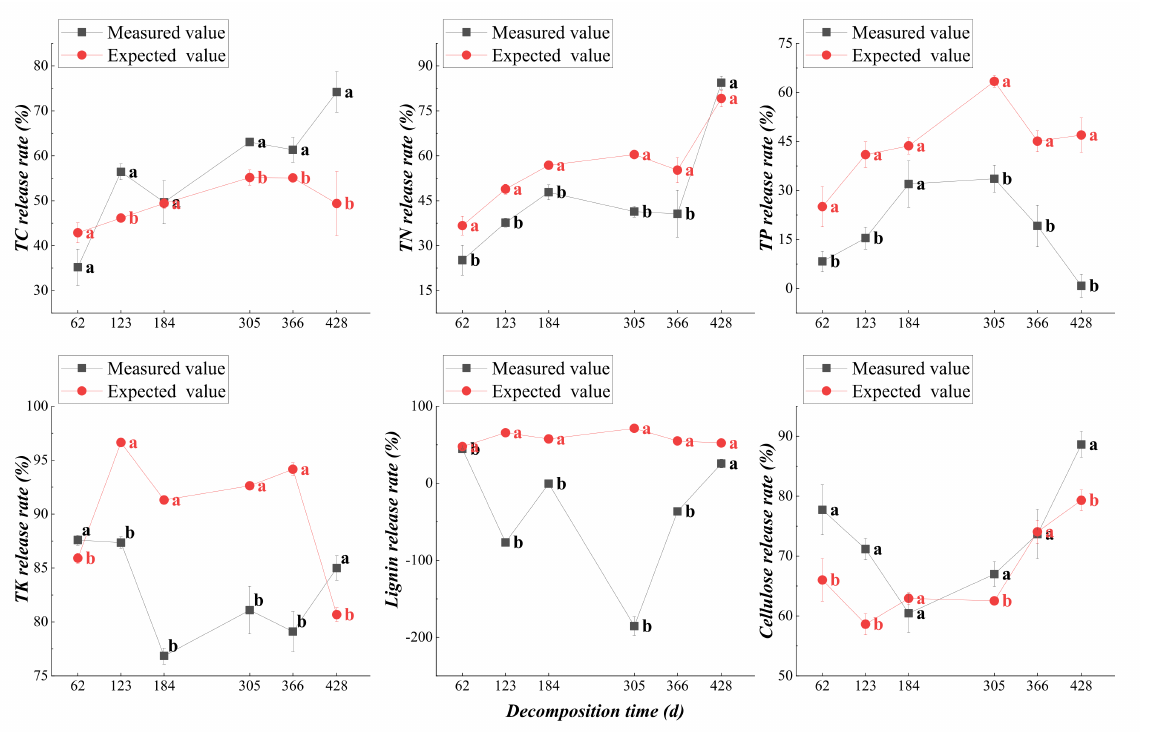
Figure 12. Measured and expected values of the nutrient release rate during CCL plant residue decomposition. Note: a, b—differences between expected value and measured value in the same decomposition period ( p < 0.05).